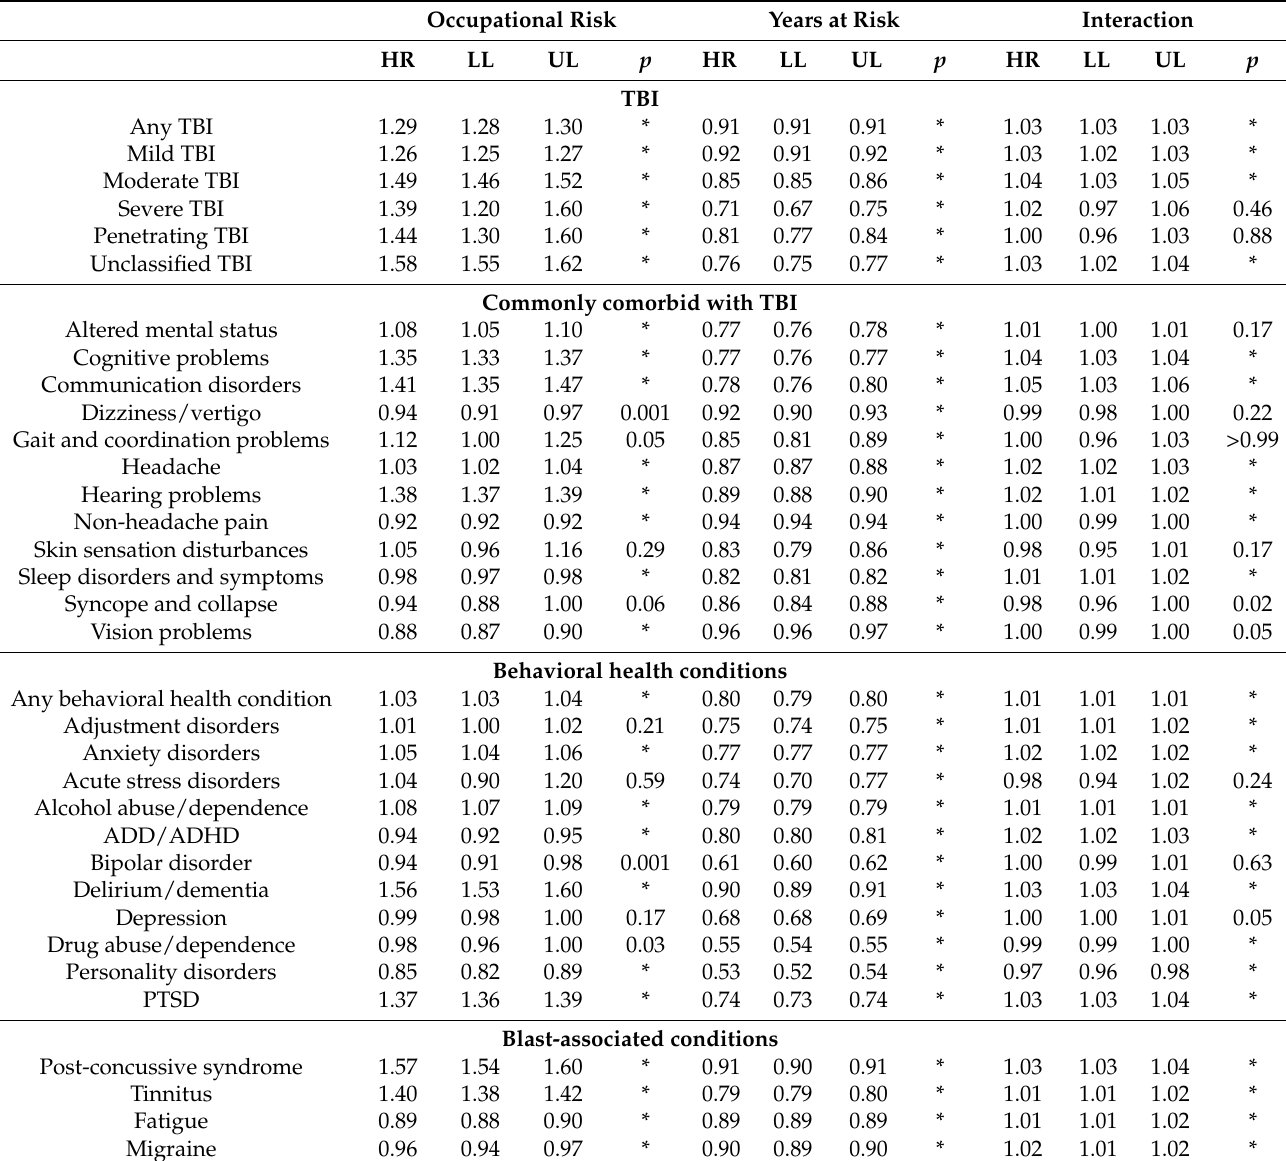
Table 2. Results of survival analyses, controlling for sex and branch of